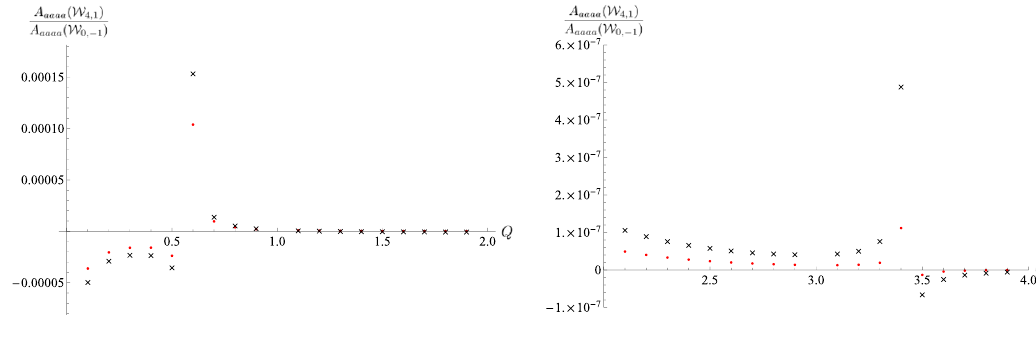
Figure 21 . The amplitude A aaaa ( W 4 , 1 ) normalized with the leading amplitude A aaaa ( W 0 , − 1 ) in P aaaa . Comparison of the lattice results (indicated with × ) and bootstrap results (indicated with • ) in the regions 0 < Q < 2 and 2 < Q < 4 .